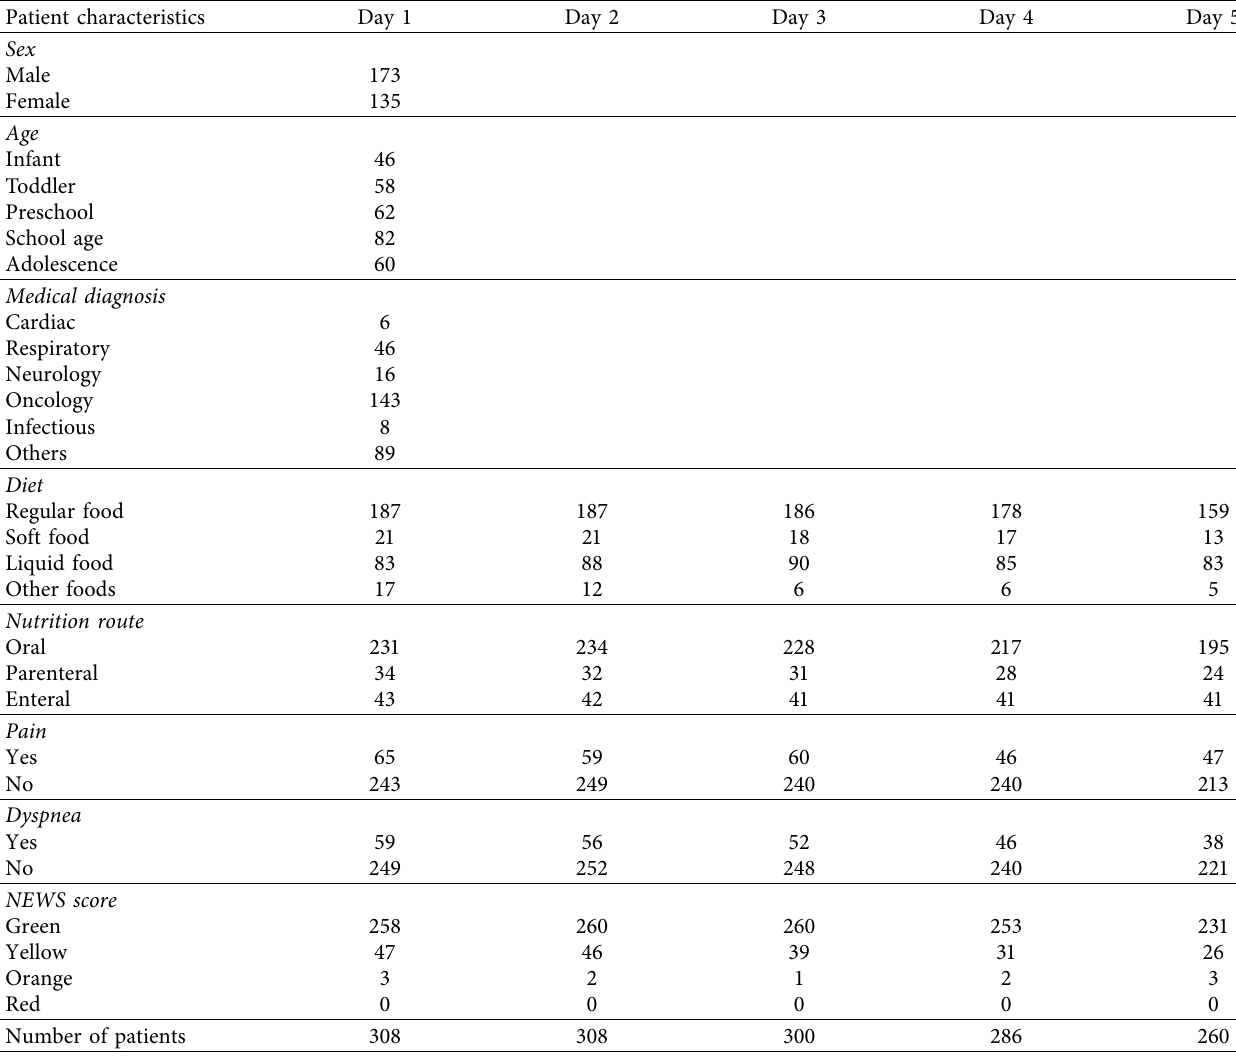
Table 2: Number of patients due to risk factors or characteristics related to HaM.